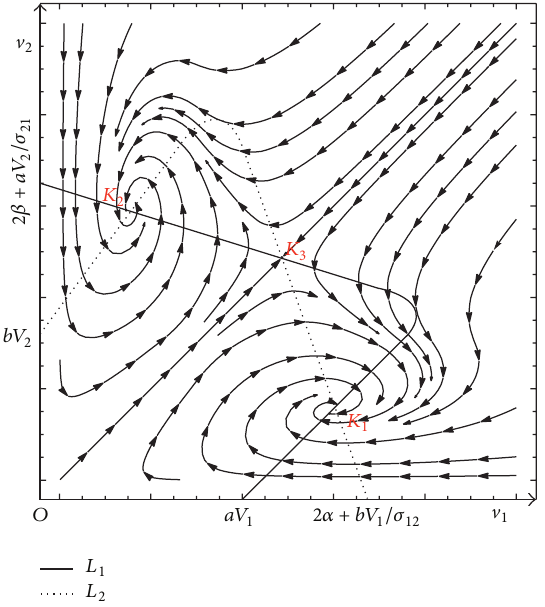
Figure 3: Three positive equilibria 𝐾 1 , 𝐾 2 , and 𝐾 3